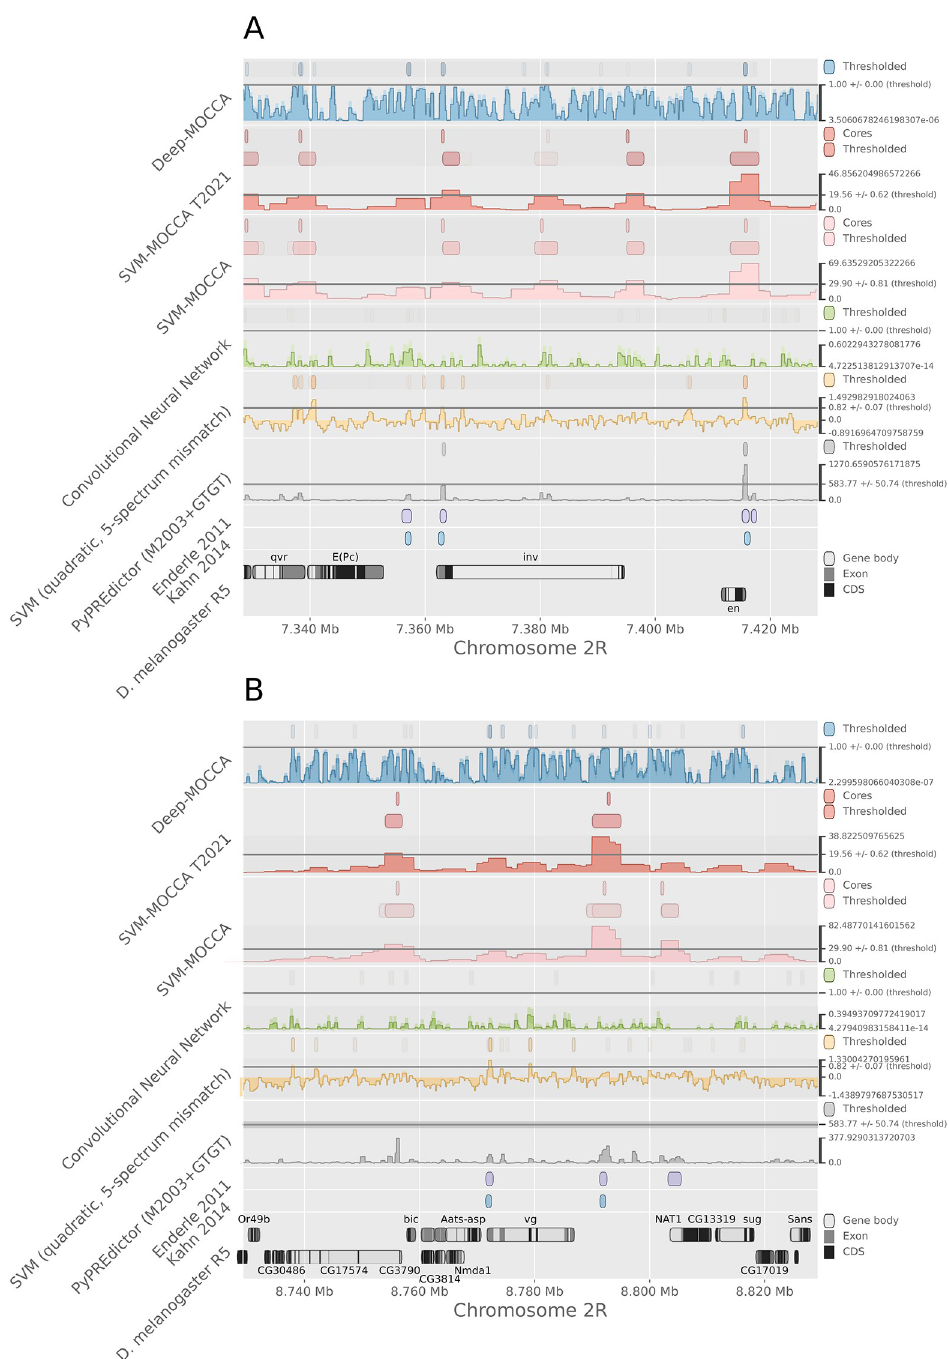
Fig 4. Predictions at the A) invected and B) vestigial loci. Visualized using the Gnocis genomic track plotting, which uses Matplotlib [26]. Opaque predictions are predicted in the majority of cross-validation repeats, and semi- transparent predictions in a subset of